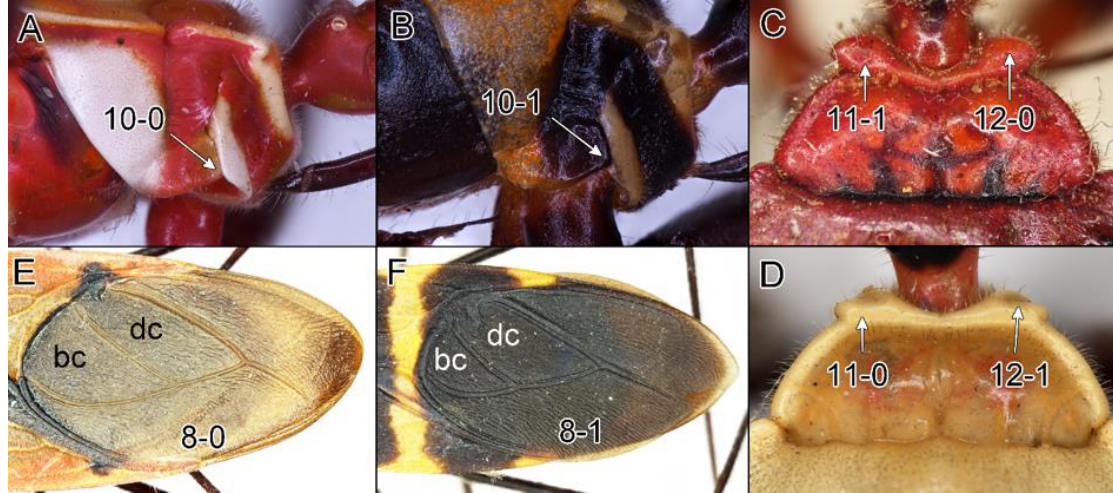
Figure 4. Morphological characters: ( A ) P. caesar Haglund, 1895 and ( B ) P. bifasciatus Villiers, 1948, thorax; ( C ) P. caesar Haglund, 1895 and ( D ) P. nigrofasciatus Stål, 1855, anterior pronotal lobe with a collar; ( E ) P. caesar Haglund, 1895 and ( F ) P. elegans Varela, 1904, hemelytron.